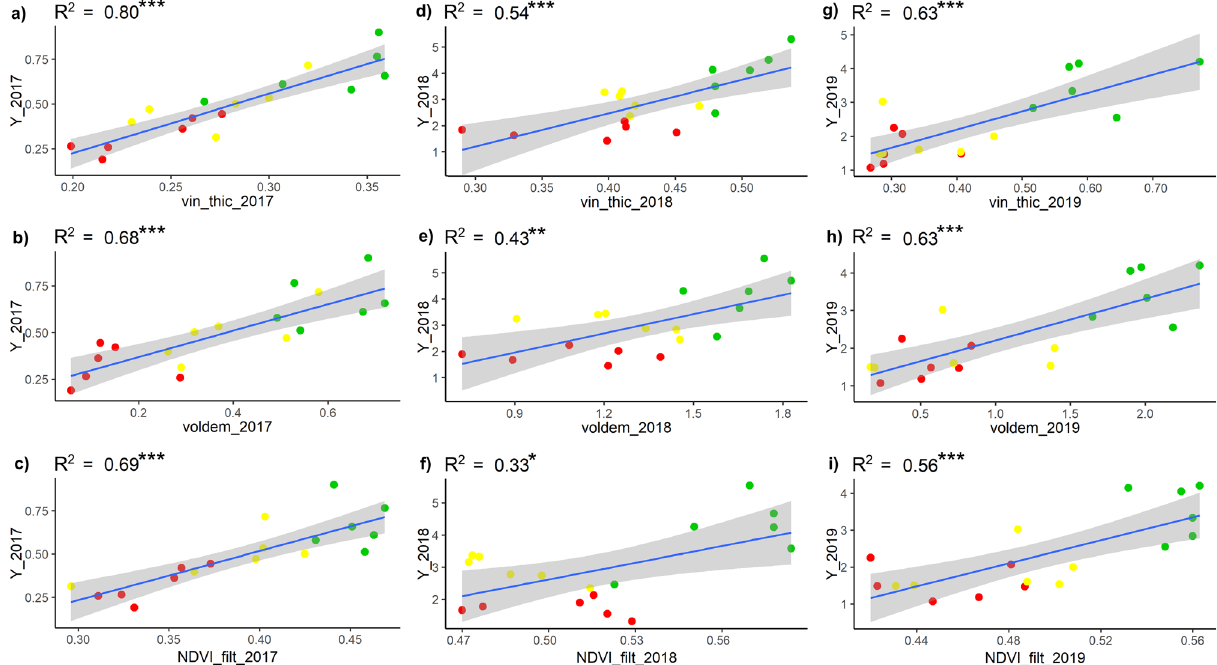
Figure 3. Linear regression results between ground measurements of yield (kg/vine) and UAV remote sensed data, represented by NDVI filtered, canopy thickness (m) and volume (m 3 ) in the HV (green dots), MV (yellow dots) and LV (red dots) zones. Significance: *** p < 0.001; ** p < 0.01; * p <